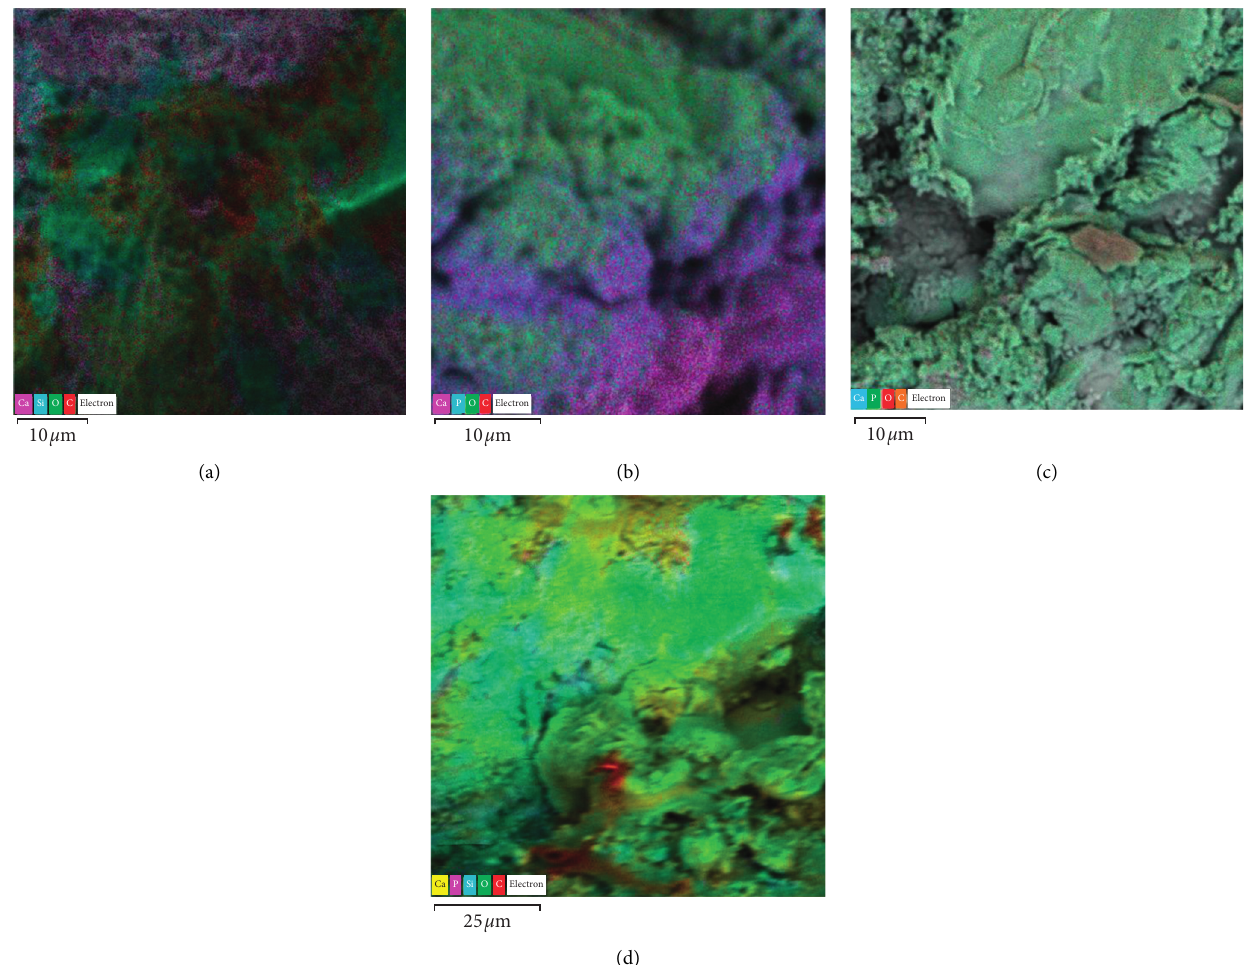
Figure 6: Elemental mapping showing the elemental distribution in the composite after immersion in SBF for 12 (a), 24 (b), 48 (c), and 72h (d). The amounts of sodium, phosphorus, and calcium varied as a function of the evaluation